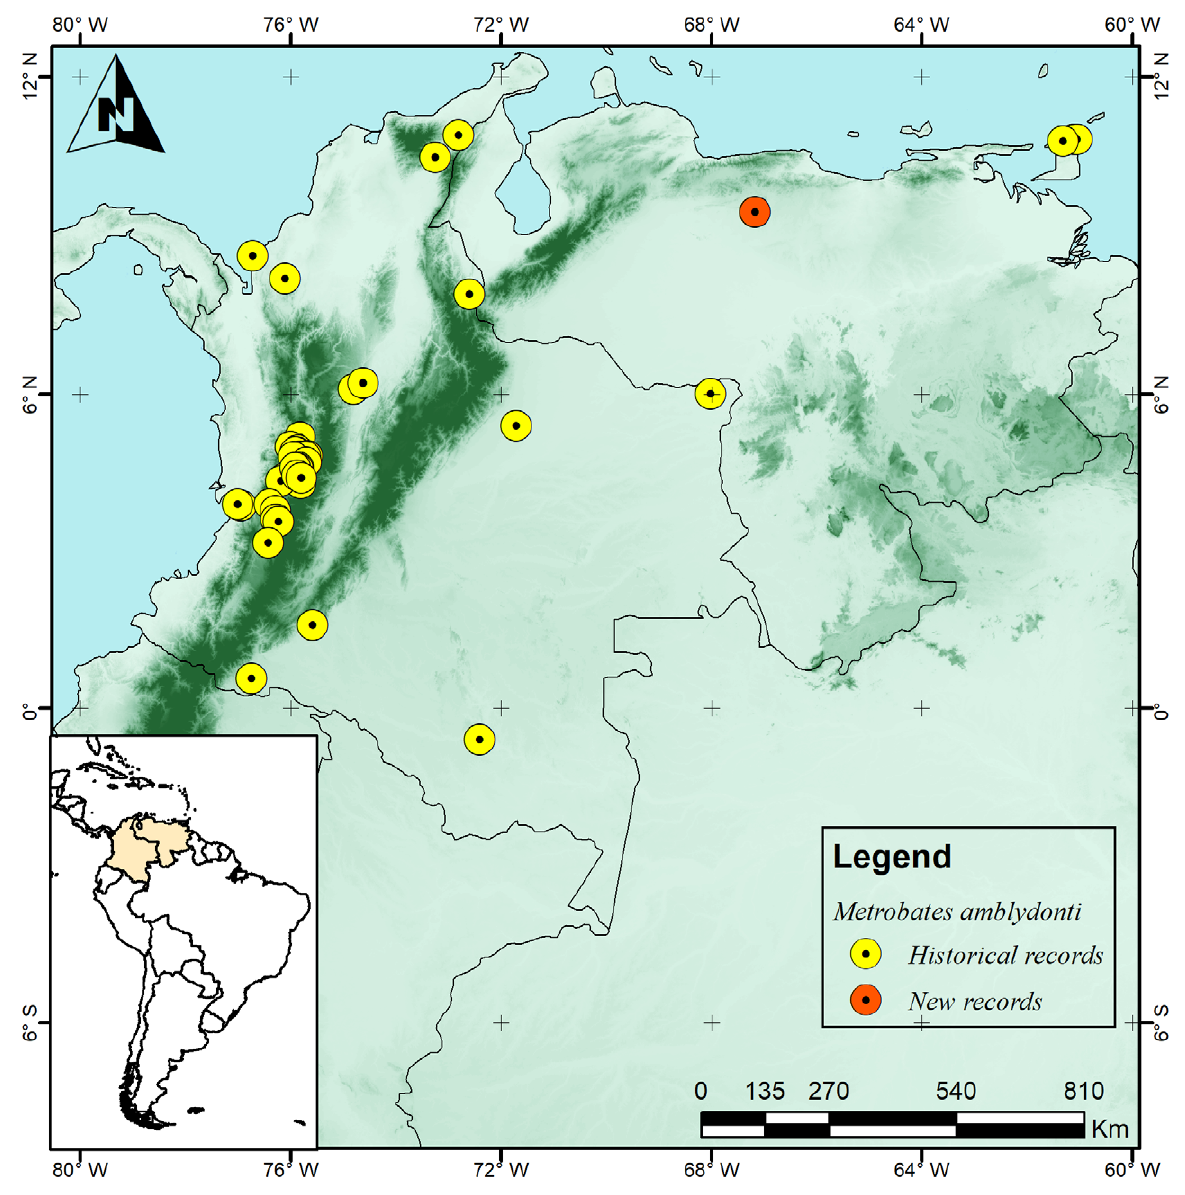
Figure 8 . Historical and new records of Metrobates amblydonti in the